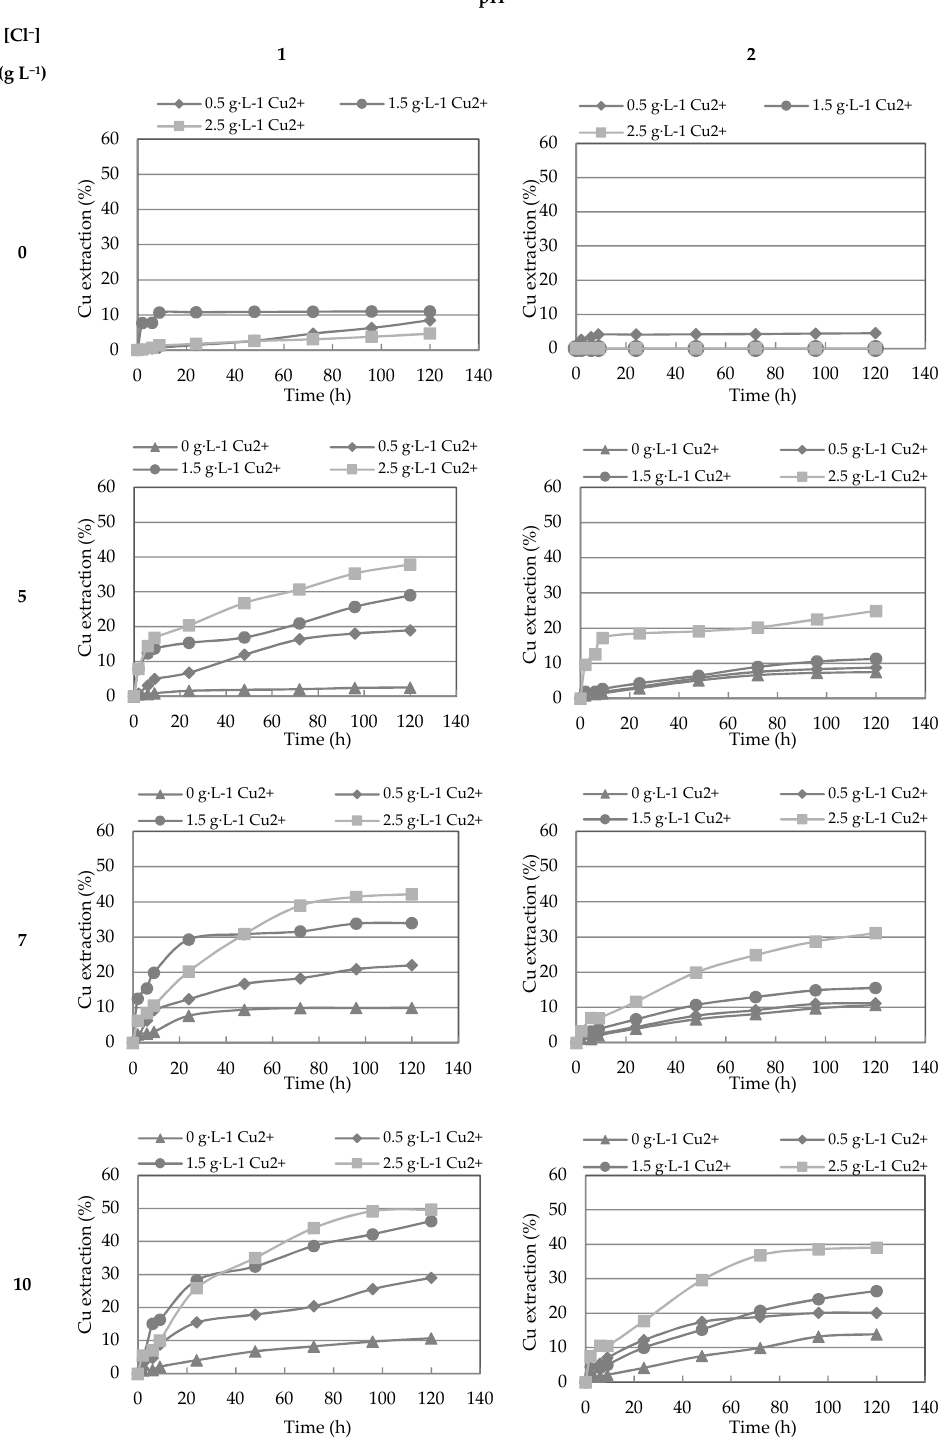
Figure 4. Cu extraction (%) with different concentration of Cu 2+ and Cl − at pH 1 and 2. ▲ : 0 g/L Cu +2 ; ♦ : 0.5 g/L Cu +2 ; ●: 1.5 g/L Cu +2 ; ■ : 2.5 g/L Cu +2 .